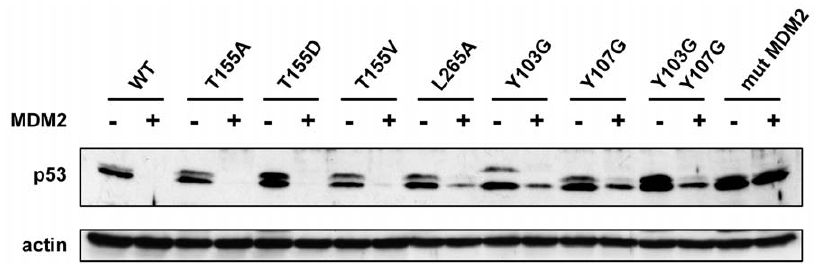
Figure 4. MDM2-mediated degradation of p53 mutants. H1299 cells were co-transfected by vectors for transient expression of MDM2 and p53 proteins. 24 h after transfection, extracted proteins were separated by 10% SDS-PAGE and analysed by Western blotting using monoclonal anti-p53